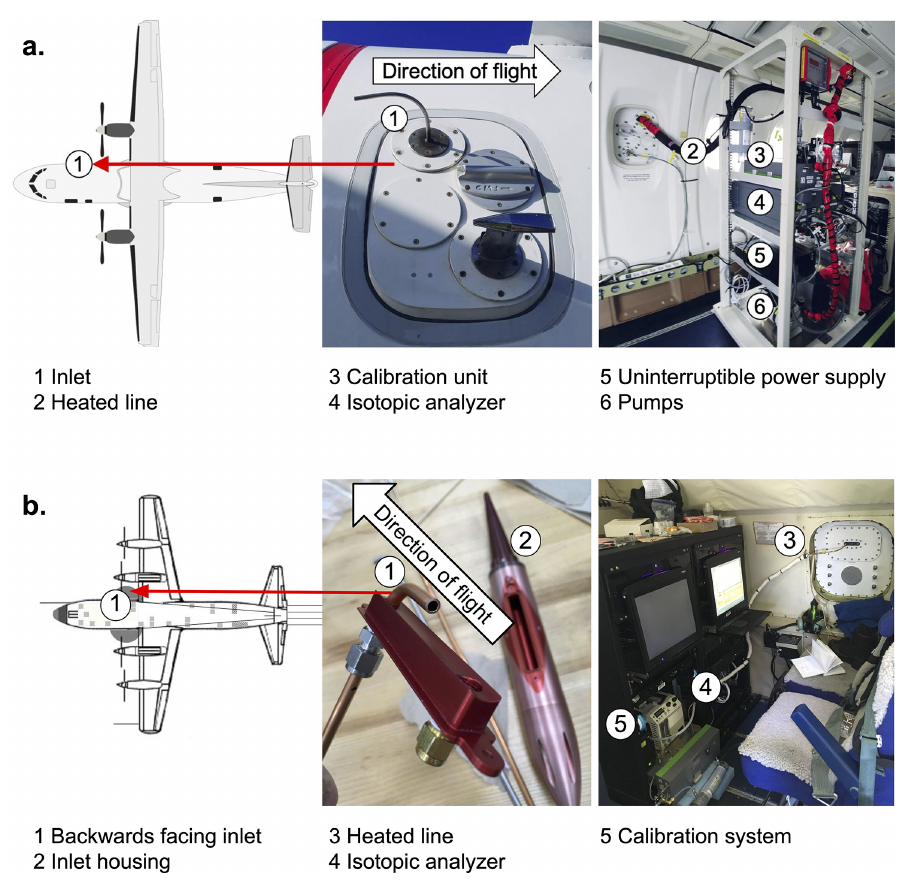
Figure 5. Water vapor isotopic sampling installations on the (a) ATR and (b) P-3 aircraft. (The ATR schematic was downloaded from https://t3projects.mpimet.mpg.de/coordination/platform-schematics (last access: 1 July 2021). The P3 schematic was provided by